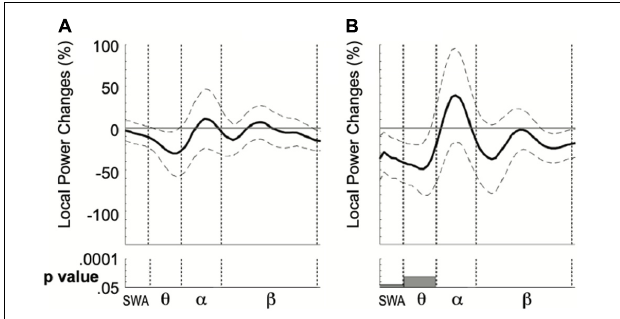
FIGURE 4 | Local mean power difference between sEEG4 and sEEG3 considering the personalized ROI in the quiet wake (A) and nap (B) group. Dotted lines indicate standard error of the mean. Bottom: results of the Paired t -tests computed for four frequency ranges.